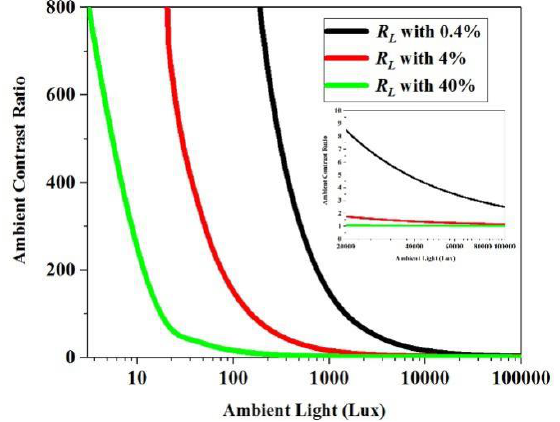
Figure 8. The CIE 1931 color coordinates chart for ( a ) di ff erent thickness of QDs-PMMA matrix; and ( b ) the di ff erent mass ratio of QDs to PMMA.